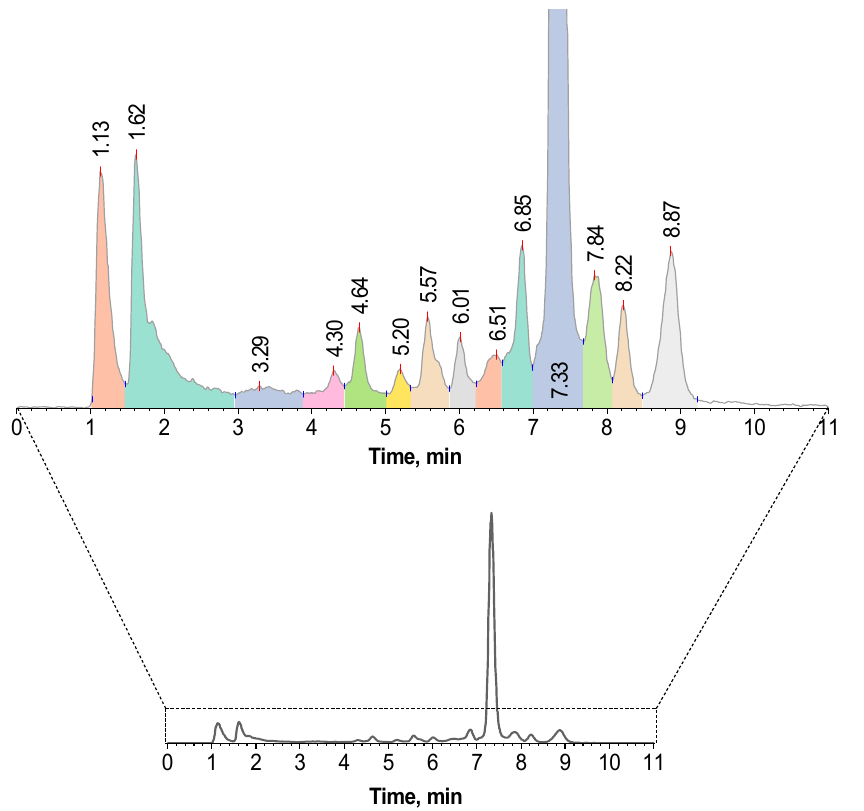
Figure 2. The radio-HPLC chromatogram of [ 177 Lu]Lu-PSMA-617 preparation obtained with HPLC method 1 at EOS time: sample volume—1 mL, 177 Lu activity in the sample—4.8 GBq, 100 μ g of PSMA-617, pH 4.5, C(Na-acetate) = 0.03 mol/L, synthesis at 95 °C for 30 min (corresponding radio-TLC chromatograms are presented in Figure 3).